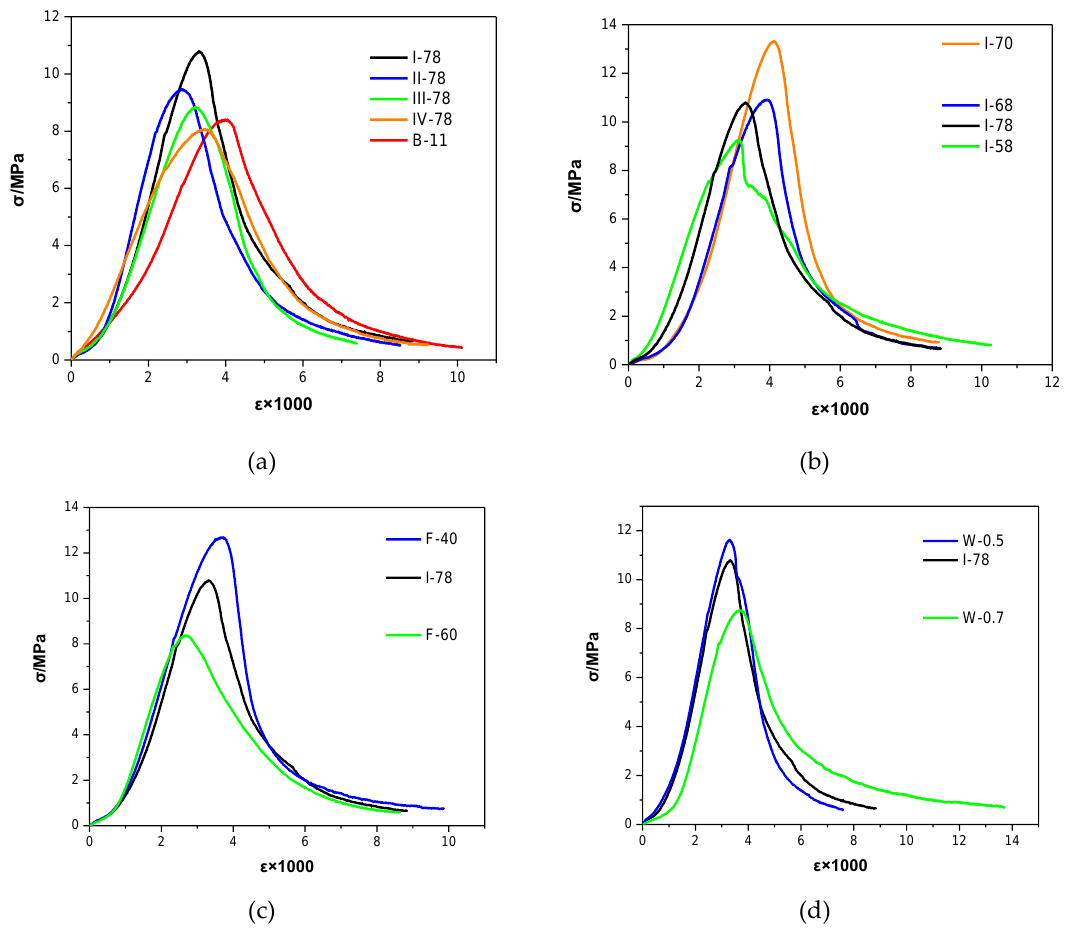
Figure 4. Comparison of stress – strain curves in different FGM specimens. ( a ) Coal gangue types and binder volume effect; ( b ) Aggregate gradation effect; ( c ) Fly ash proportion effect; ( d ) Water to binder ratio effect.